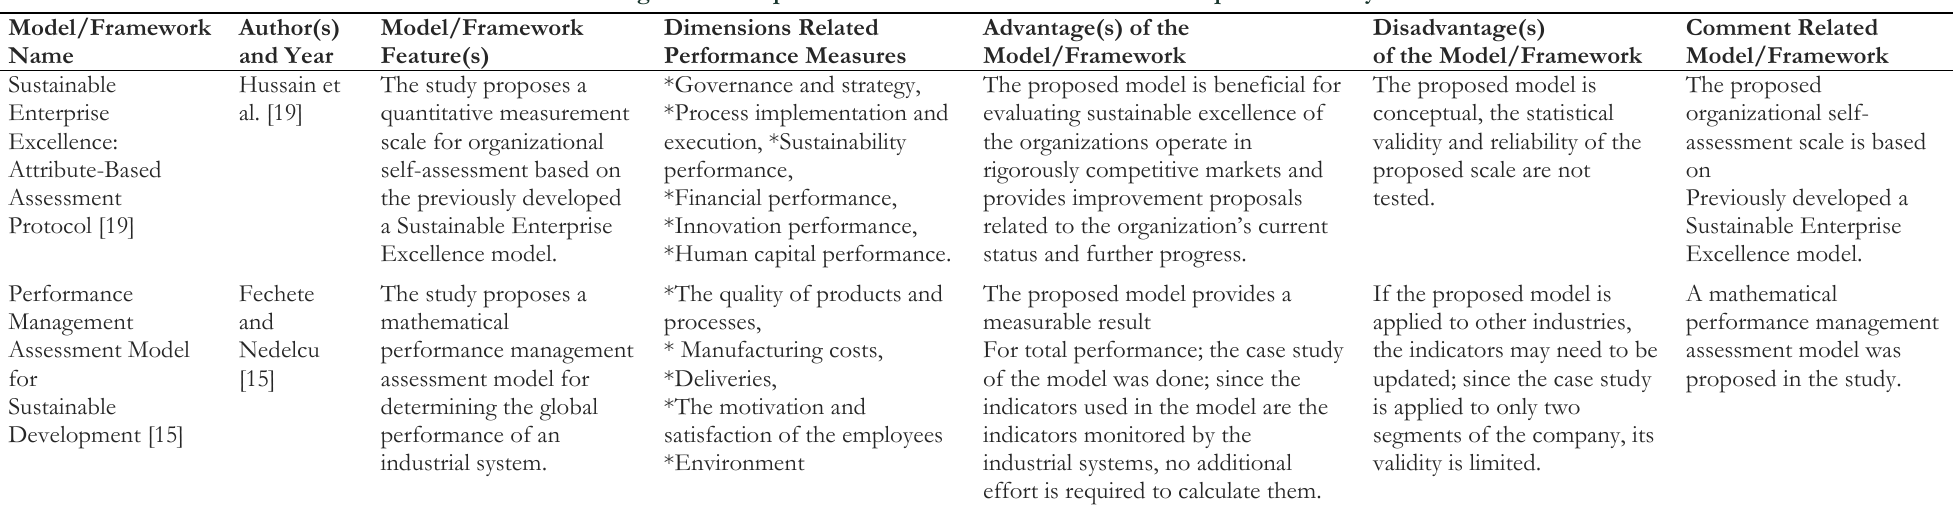
Table 6. Organizational performance measurement models developed in Industry